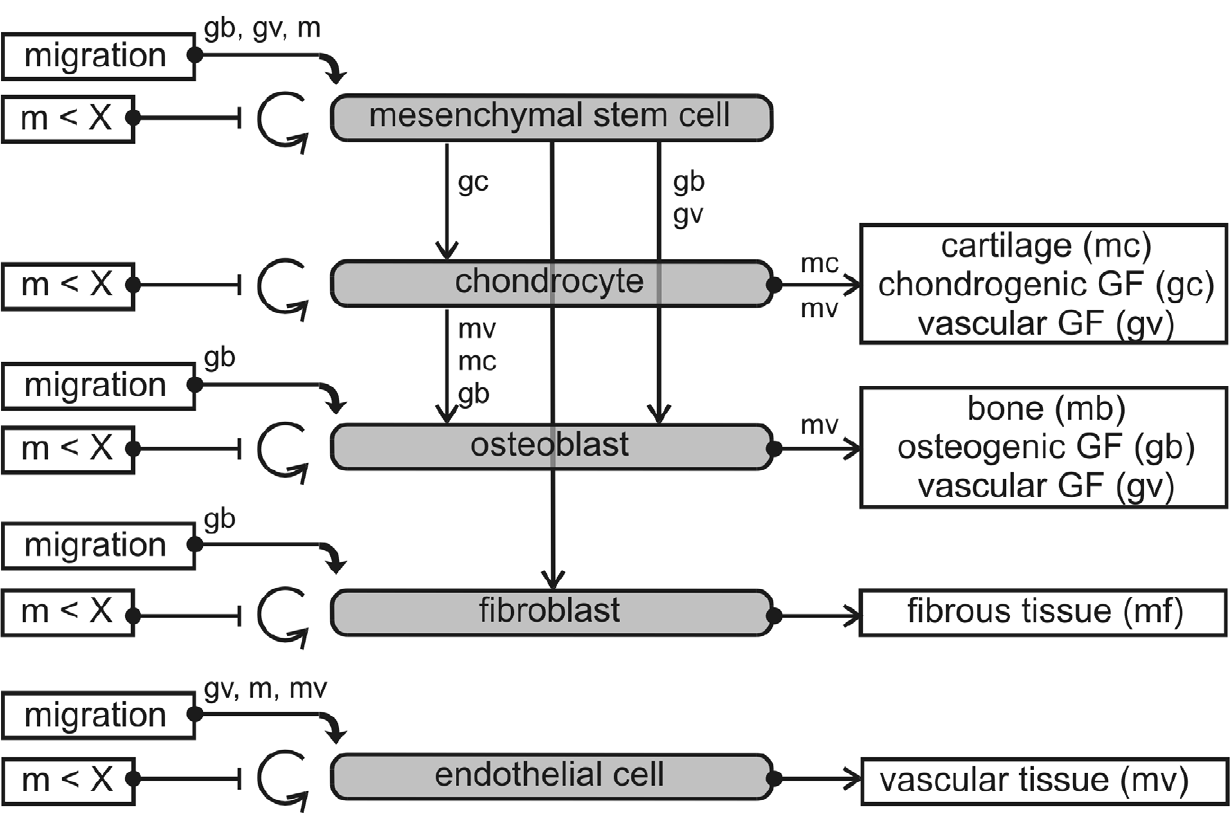
Figure 1. Schematic representation of the mathematical model. Legend: GF=growth factor, m=mf + mc + mb + mv=total tissue density, X=maximum tissue density for proliferation. The involvement of a variable in a regeneration subprocess is indicated by showing the name of that variable next to the arrow representing that particular process, e.g. the vascular matrix density (mv) interferes with cell migration, endochondral ossification and GF production.